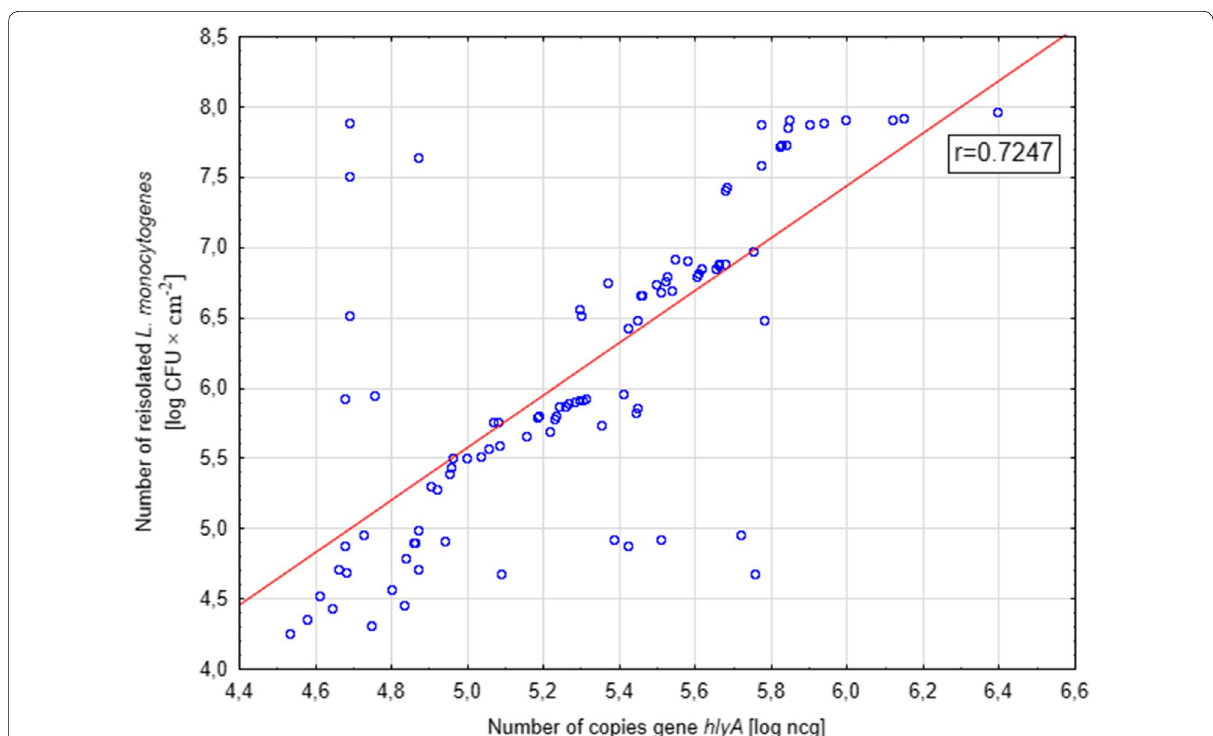
Fig. 4 Correlation between the number of bacteria reisolated from the steel surface and the number of copies of the hlyA gene in the sample for the tested strains of L.